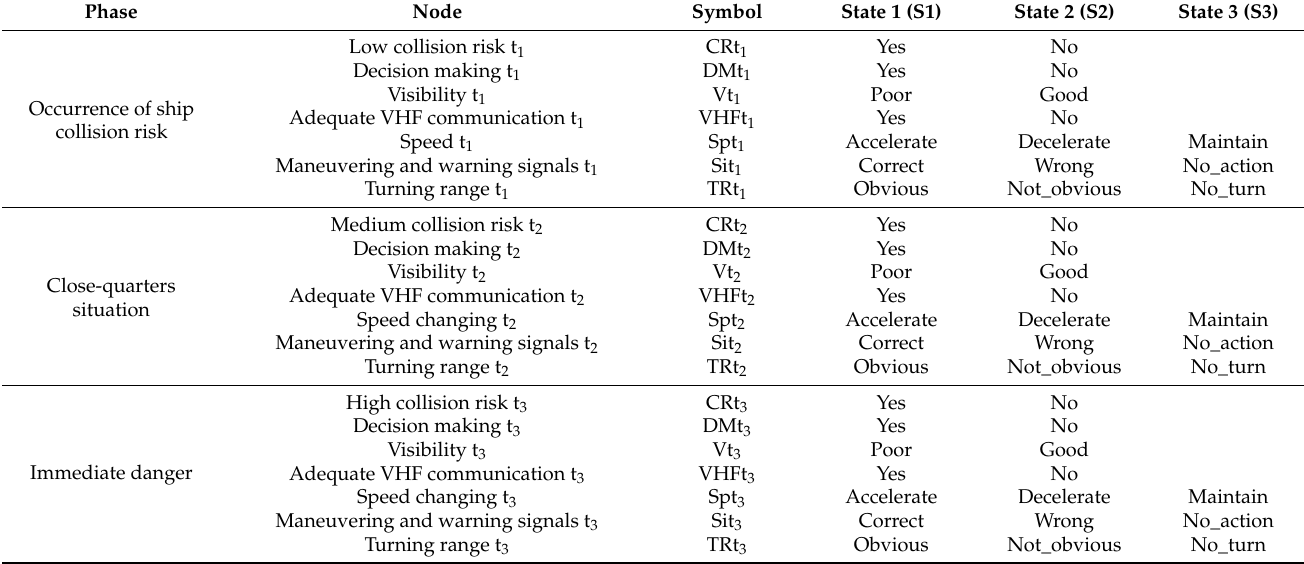
Table 5. Definitions and states of the DBN